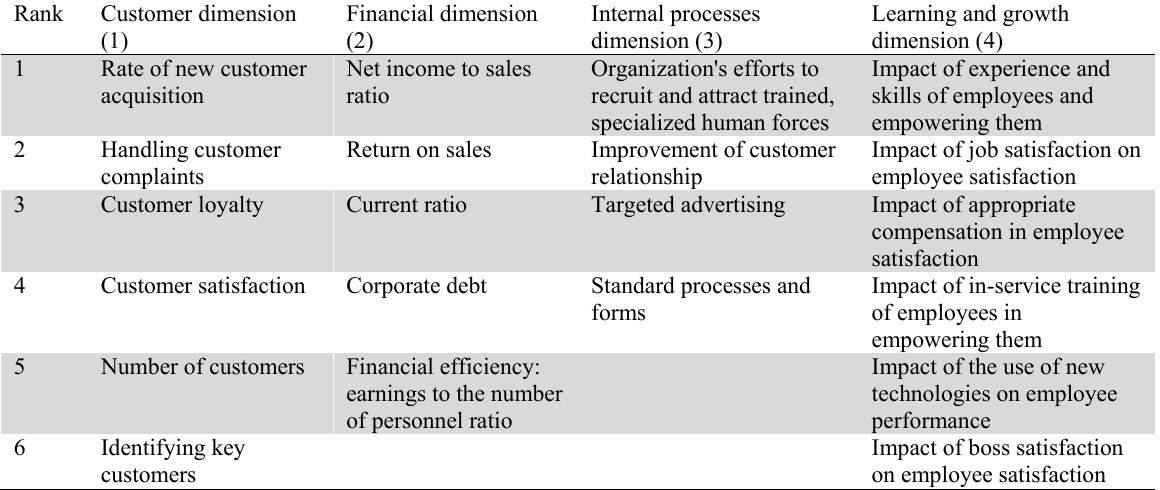
Fig. 1. The output of final ranking of criteria and sub-criteria used in performance evaluation of Shirin Asal branches is given in Table 9.